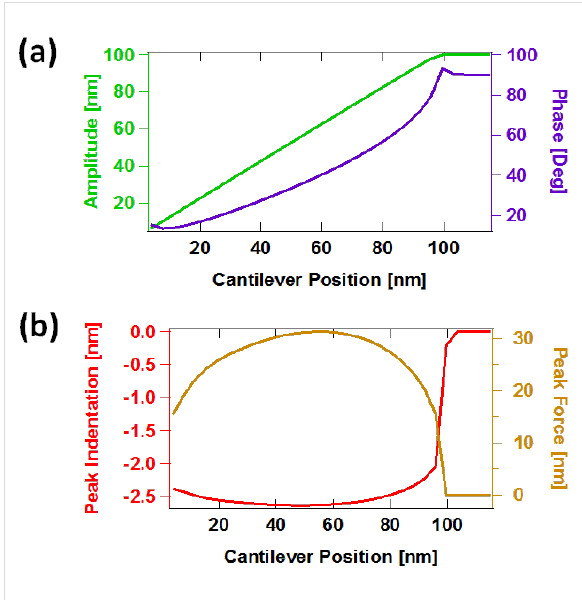
Figure 6: Examples of spectroscopy curves: (a) amplitude and phase vs cantilever position; (b) peak indentation and peak force vs cantilever position (these two quantities are not directly observable in a spec- troscopy experiment). The simulation parameters are the same as for monomodal AFM in Figure